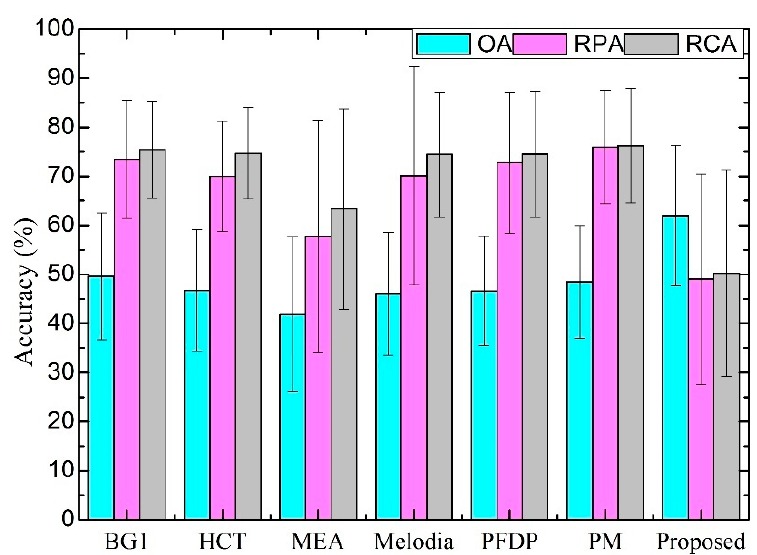
Figure 6. Accuracies on MIREX05.